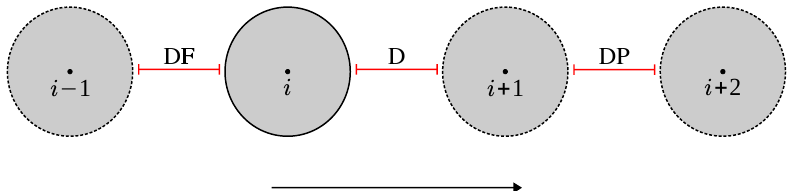
Figure 4. Illustration of pedestrians’ positions in 1D scenario, indicating the investigated head- way distances.